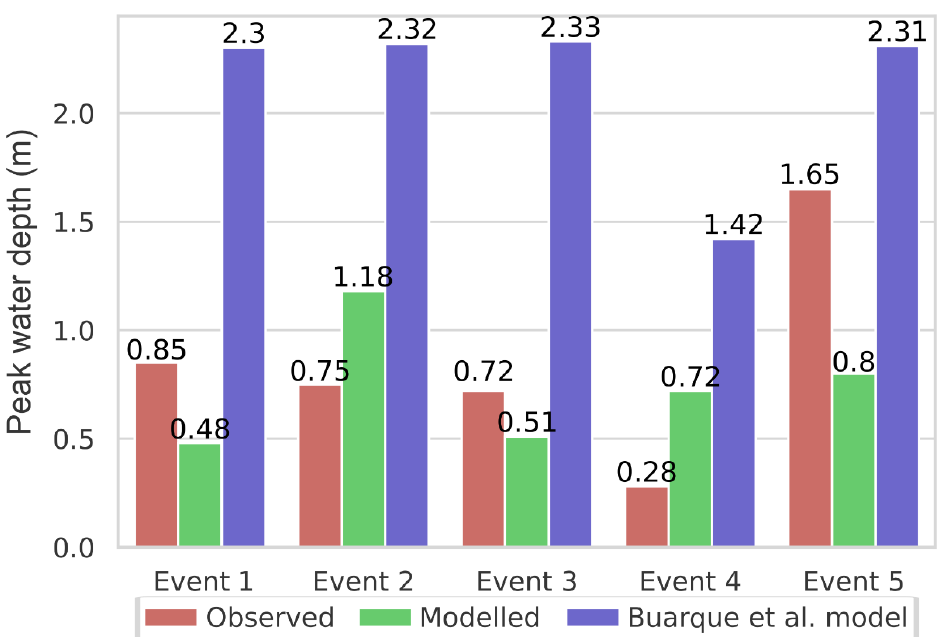
Figure 3. Comparison between observed water depth with maximum water depth reached at the closest pixel to the observation using HEC ‐ RAS and CAFLOOD (Buarque et al. 2021).